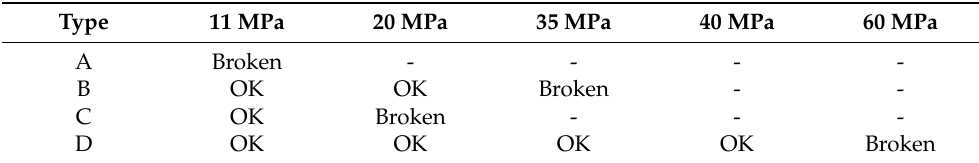
Table 4. Dimensional information of the microsensor model in FEA